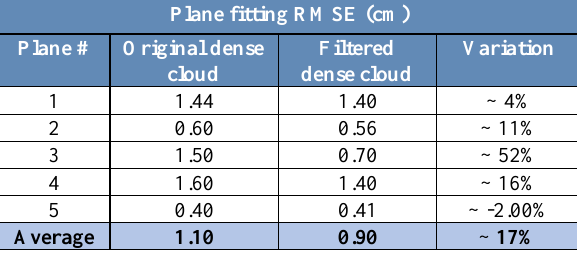
Table 5: Improvement of the average plane fitting RMSE on five selected planar areas, considering the original and the filtered dense point clouds.